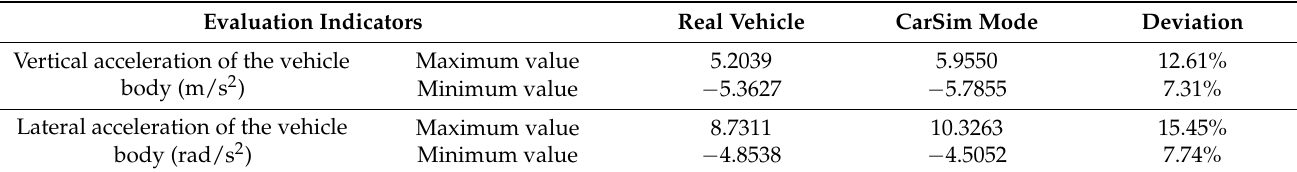
Table 6. Time domain response of vehicle body passing over a triangular speed bump.